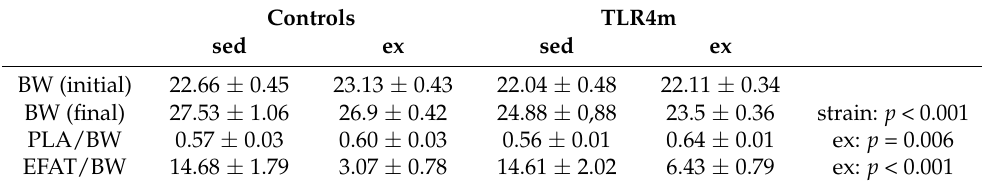
Table 1. Body weight, plantaris muscle weight, and epididymal fat